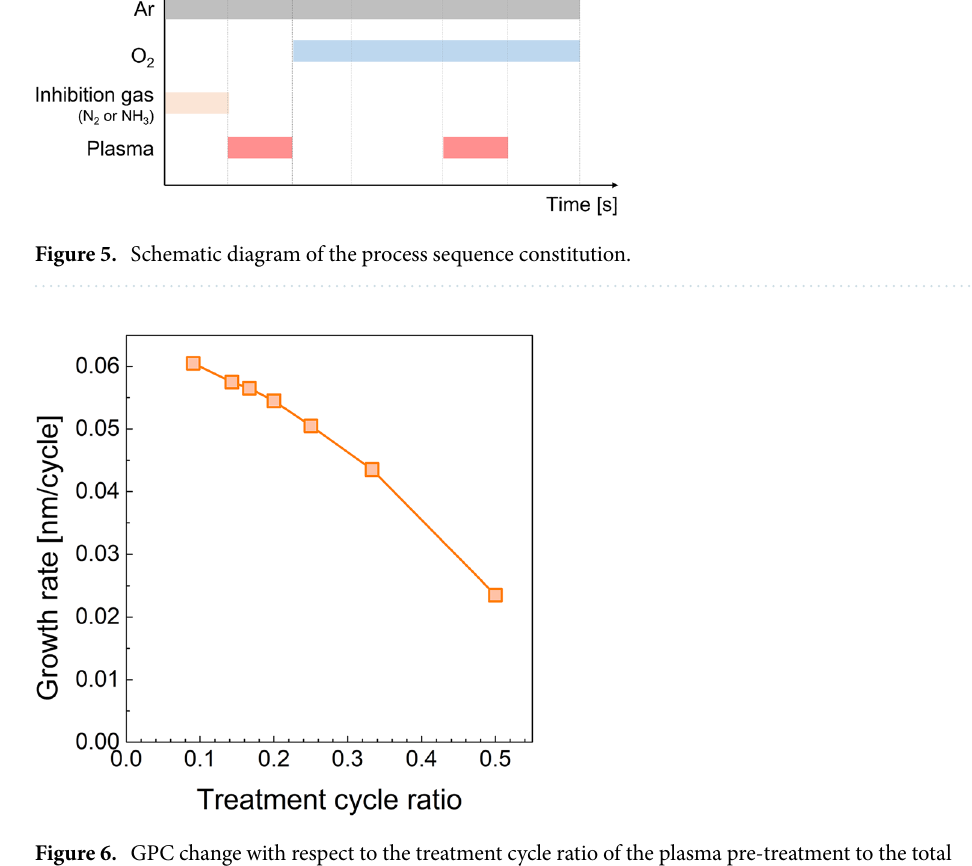
Figure 6. GPC change with respect to the treatment cycle ratio of the plasma pre-treatment to the total PE-ALD sequence as shown in Fig.